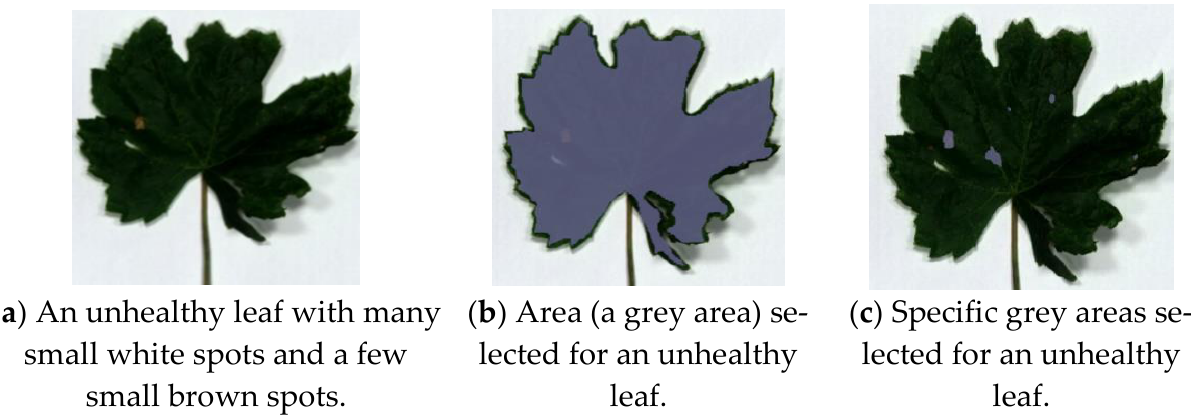
Figure 3. Unhealthy leaf with white spots and few brown spots and its selected areas for data cube acquisition.